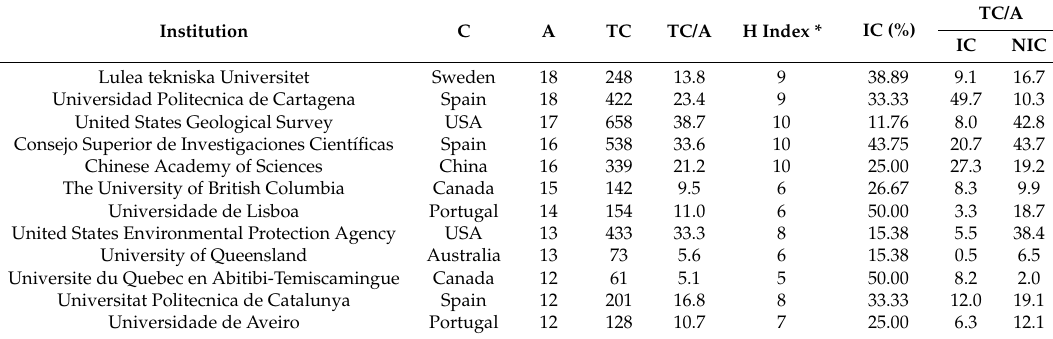
Table 11. Most productive institutions in MMW